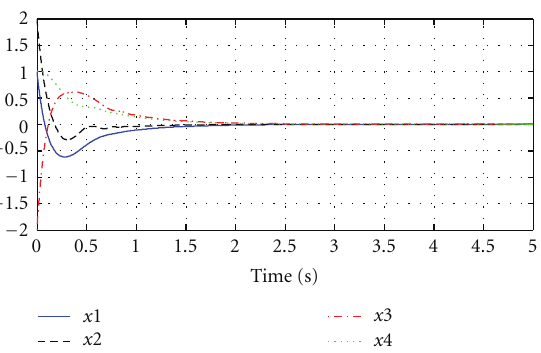
Figure 8: Sliding variables with applying the proposed